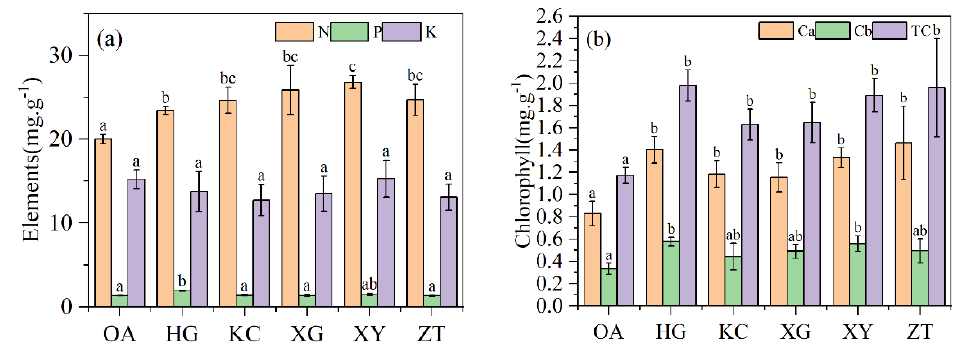
Figure 3. Nutrient content ( a ) and leaf chlorophyll content ( b ) of Qi-Nan and OA. Different letters denote significant ( p < 0.05) differences among OA and five Qi-Nan clones in a one-way ANOVA, and the bar represents standard deviation ( n = 3). “N” nitrogen; “P” phosphorus; “K” potassium, “Ca” Chlorophyll a, “Cb” Chlorophyll b, “TC” total chlorophyll.